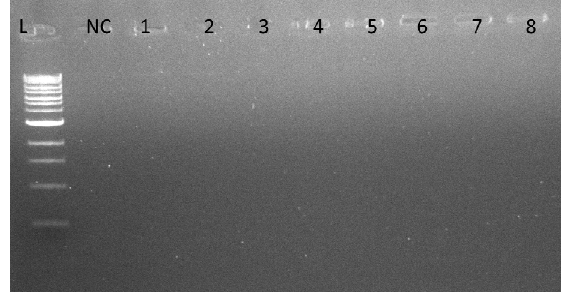
Fig. 2. Plasmid profile of cured Pseudomonas sp. and Staphylococcus sp. isolated from soil samples, analyzed with 0.8% agarose gel electrophoresis stained with ethidium bromide Key: L is 0.5kb - 48.5kb DNA ladder (molecular marker). Samples 1, 2, 3, 4, 5, 6, 7 and 8 are negative for plasmid genes . NC is a no plasmid DNA template